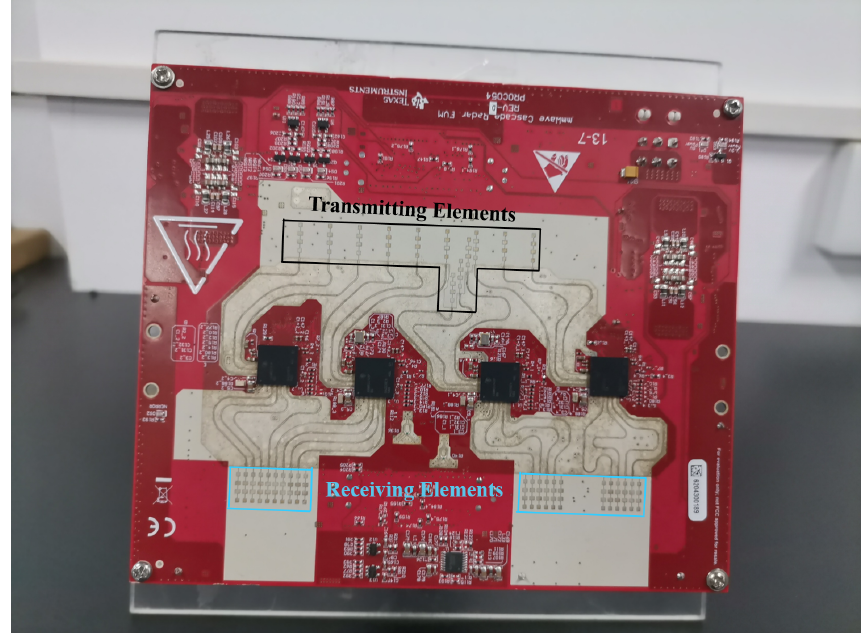
Figure 1. Texas Instruments’ cascaded FMCW-MIMO radar